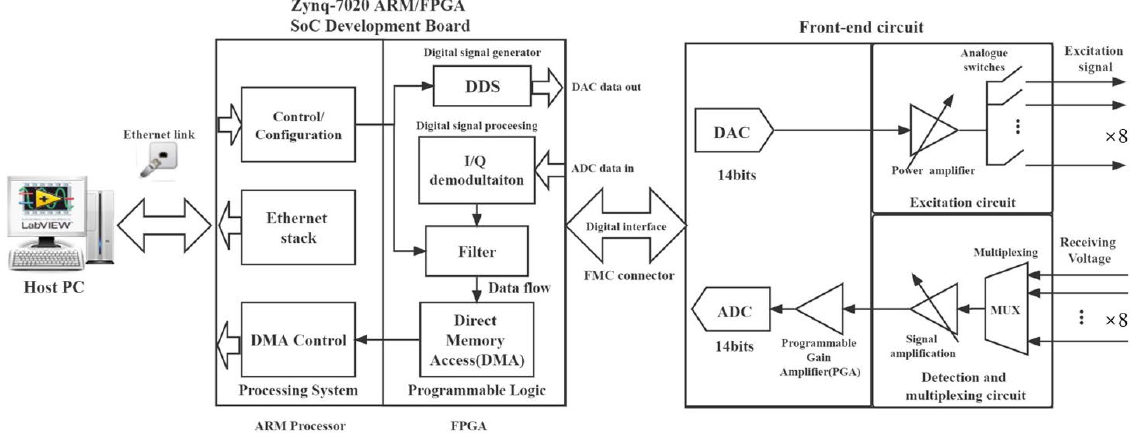
Figure 10. System architecture of the customized EC testing instrument.